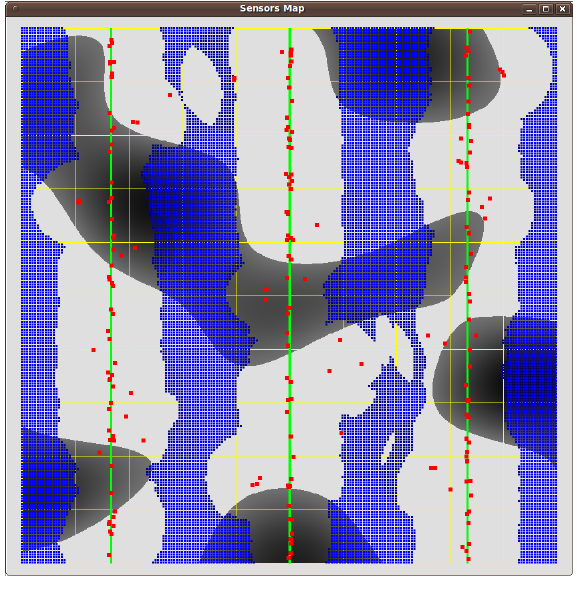
Figure 11. A sensor deployment for θ = 0 . 9 .